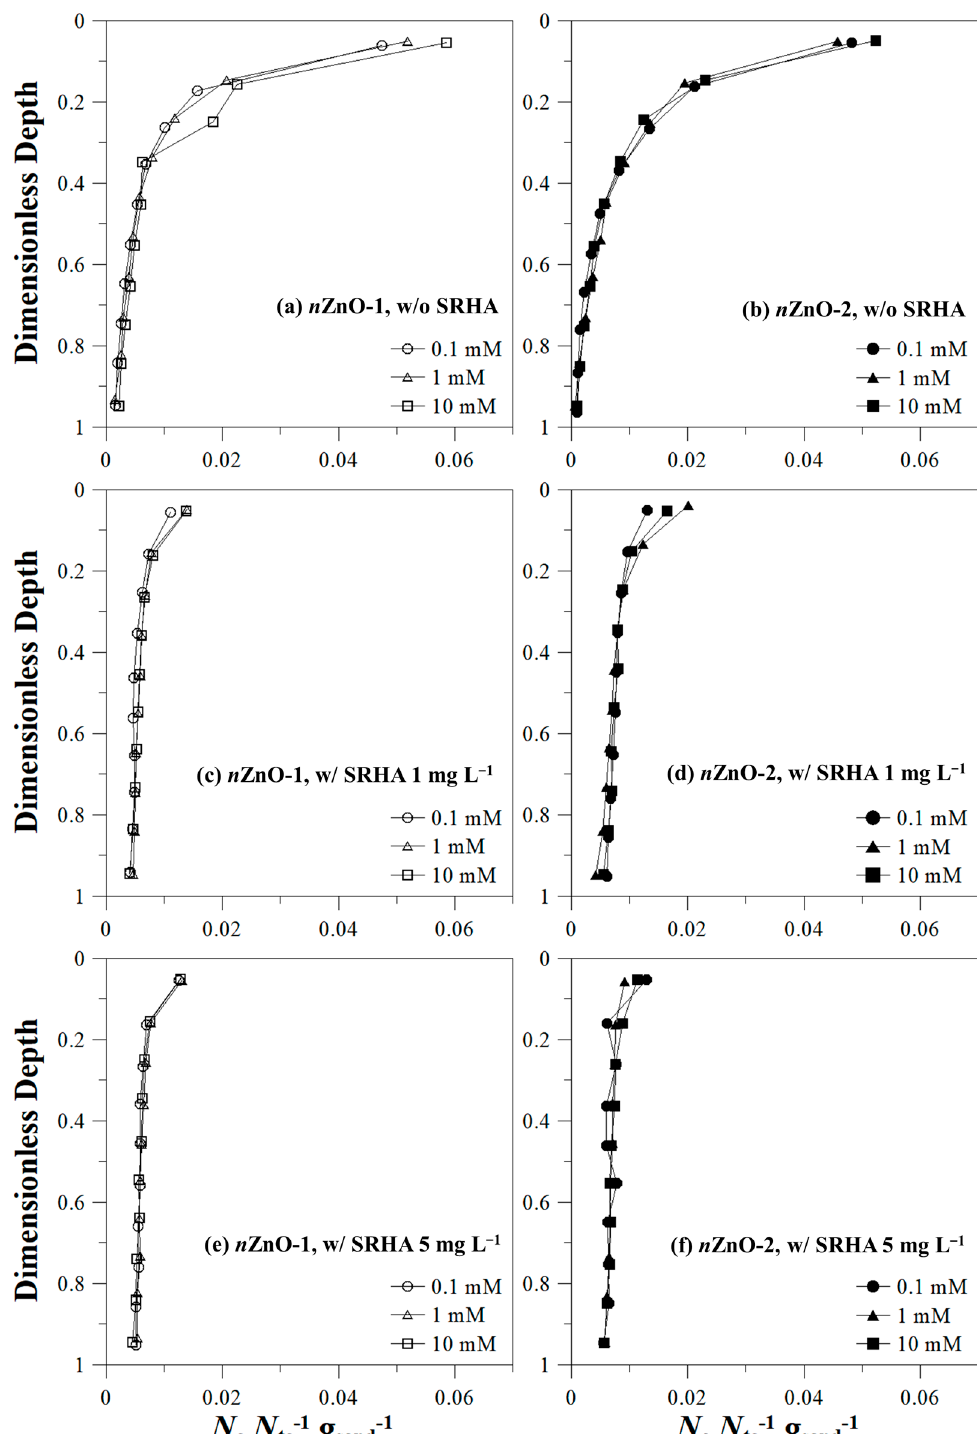
Figure 4. Retention profiles of n ZnO-1 (open symbol) and n ZnO-2 (solid symbol) in the absence ( a , b ) and presence ( c – f ) of suspended SRHA and at difference ionic strengths in NaCl (0.1–10 mM). Here, the dimensionless depth represents the normalized column depth (i.e., column depth at certain position divided by total length of the column). The x-axis represents the normalized concentration of NPs deposited at a certain depth per unit sand mass; N c , N tc , and g sand represent the number of the deposited NPs, the number of total NPs injected to the column, and the sand weight at a certain depth, respectively.